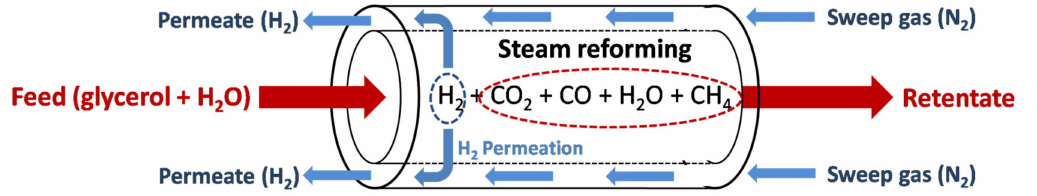
Figure 6. Basic representation of glycerol steam reforming in a membrane reactor, with the inner cylinder representing the membrane (inspired by Macedo et al.